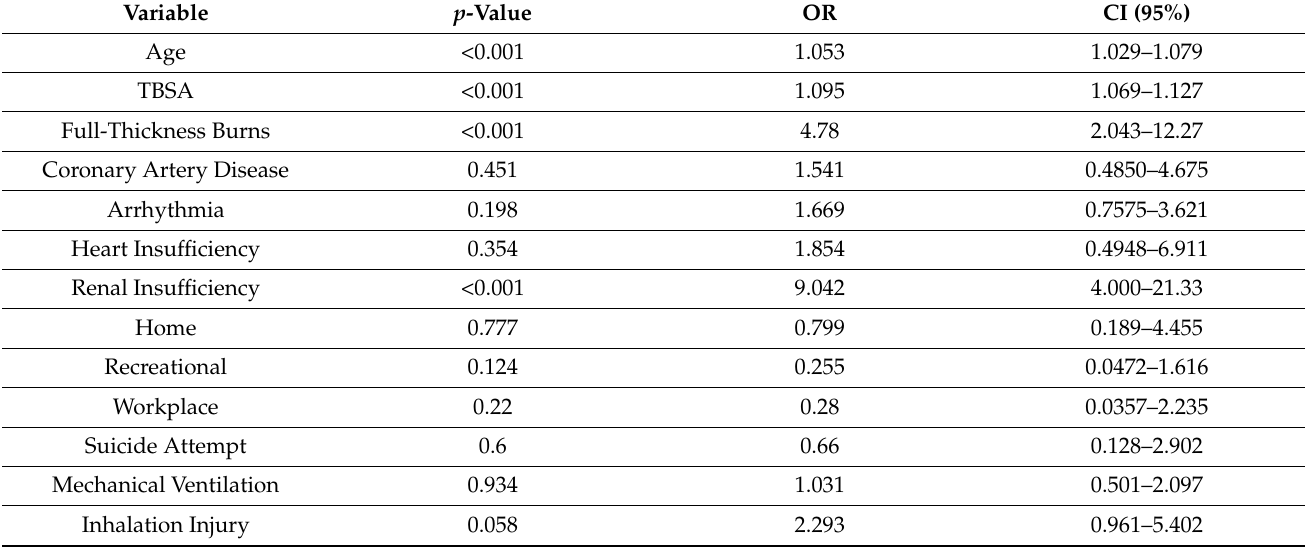
Table 3. Multivariate analysis of